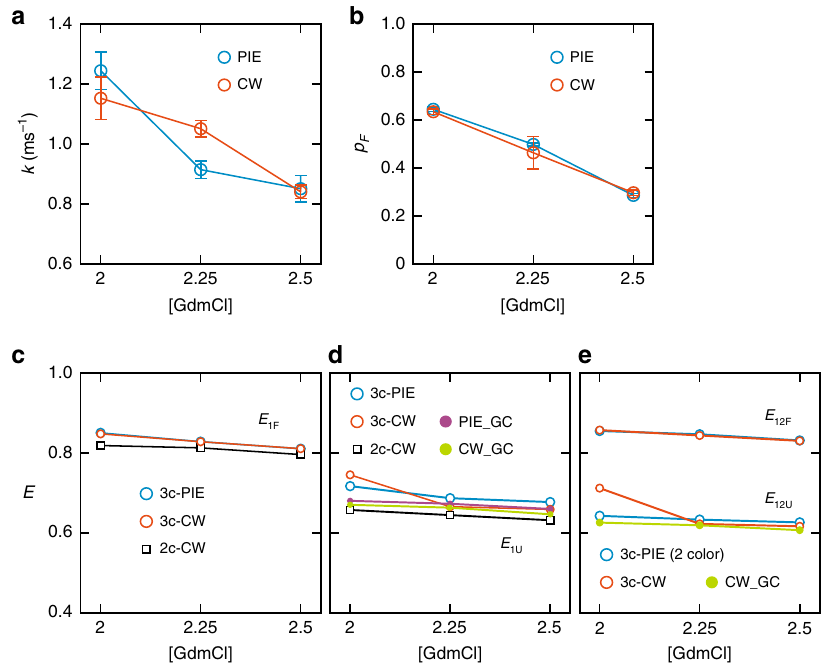
Fig. 4 Extracted parameters of α 3 D folding from 3c-PIE and 3c-CW. a Relaxation rate k ( = k F + k U ) from 3c-PIE (blue) and 3c-CW (red). b Fraction of the folded state p F from 3c-PIE (blue) and 3c-CW (red). c Folded state FRET ef fi ciency E 1F from two color (black), 3c-PIE (blue), and 3c-CW (red). d Unfolded state FRET ef fi ciency E 1U from two color (black), 3c-PIE (blue), 3c-CW (red), and E 1U 3c calculated using the Gaussian chain model with parameters obtained from two-color FRET ef fi ciency for 3c-CW (green) and 3c-PIE (purple) (see Methods). In c , d , E 1 3c values of 3c-CW were determined using E 2 2c from two-color (DA2) segments. E 1 3c values of 3c-PIE were calculated using E 12 2c obtained from A1 excitation. e FRET ef fi ciencies between A1 and A2 in the folded ( E 12F 2c ) and unfolded ( E 12U 2c ) states in 3c-CW using two-color E 2 2c (red), the unfolded state FRET ef fi ciency calculated using the Gaussian chain model (green), and E 12F 2c and E 12U 2c determined from 3c-PIE by A1 excitation (blue). Error bars are standard deviations calculated from the curvature at the maximum of the likelihood function. Source data are provided as a Source Data fi